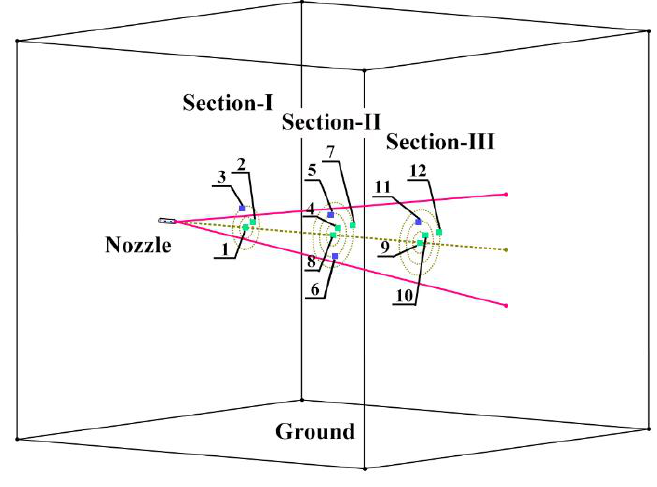
Figure 2. The location of sampling points.